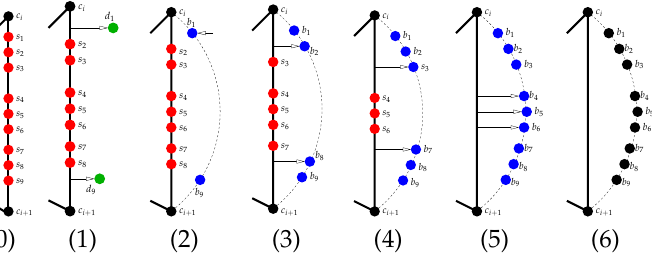
Figure 16. Stage 2 sub-stages. Part ( i ) shows the configuration of a side at the end of the i th sub-stage or the beginning of the ( i + 1 ) th sub-stage. The figure shows corners, side robots, scouts, and beacons as black, red, green, and blue